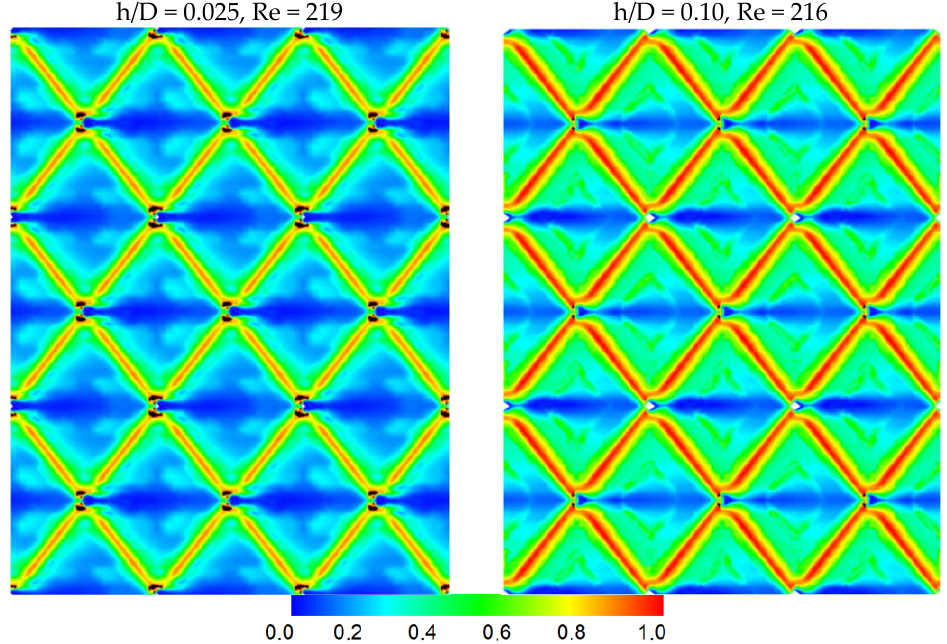
Figure 4. Typical spatial distribution of the local time-averaged shear stresses on the membrane surface for the same mean flow rate (and Re) and different gap reduction, i.e., h/D = 0.025 and 0.10.